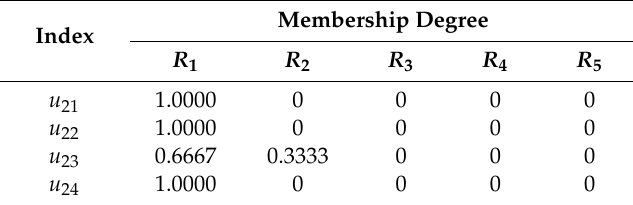
Table 10. Membership degrees of SCADA HMI software influencing factors (R u 2 ).